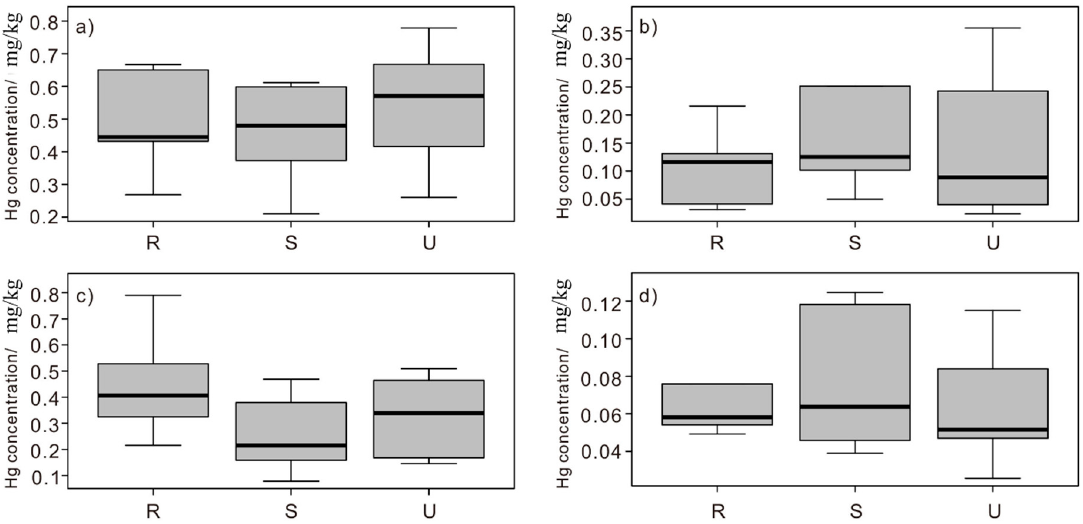
Figure 3. Comparison of mercury concentrations in different land-use types of four environmental media, ( a ) road dust, ( b ) foliar dust, ( c ) soil, and ( d ) camphor tree leaves. R: rural area (R1–R9); S: suburban industrial area (S1–S9); U: urban area (U1–U14). The solid lines within boxes show the median values of each group. The upper and lower boundary of the boxes indicates the 25th and 75th percentiles. Horizontal lines represent the maximum and minimum values.